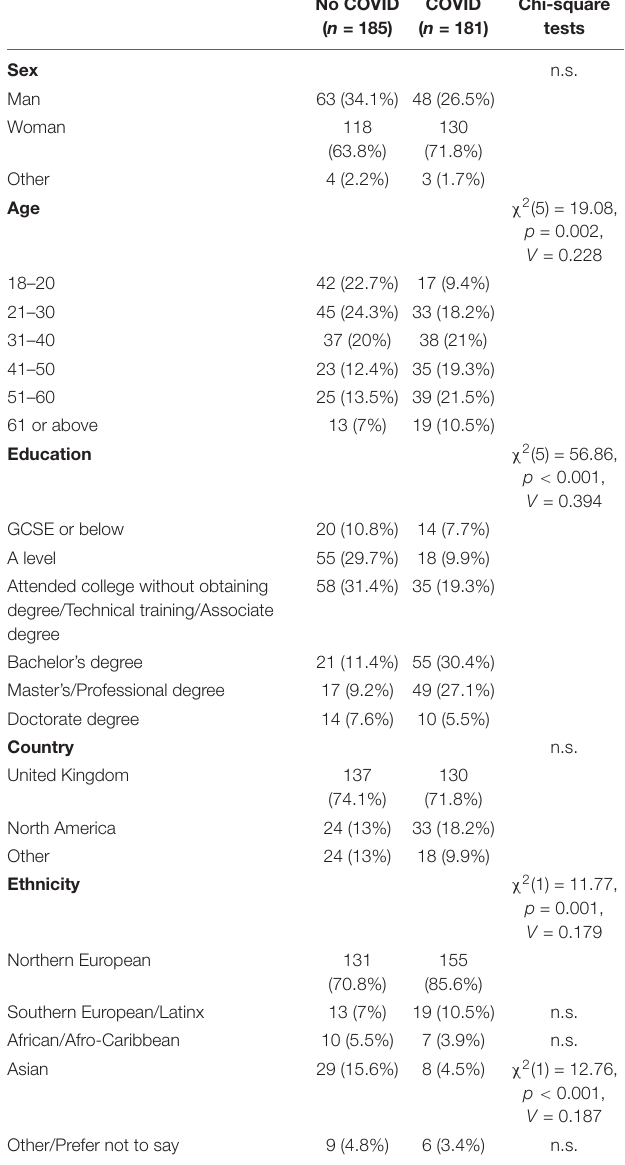
TABLE 1 | Distribution of demographics in No COVID and COVID